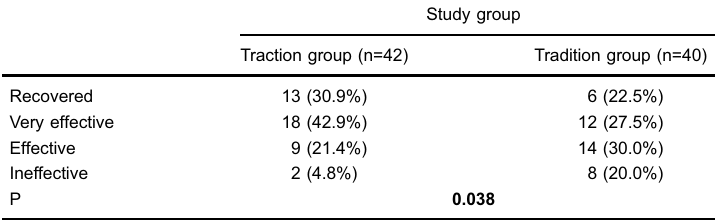
Table 2. Comparison of overall clinical ef fi cacy before and after intervention.